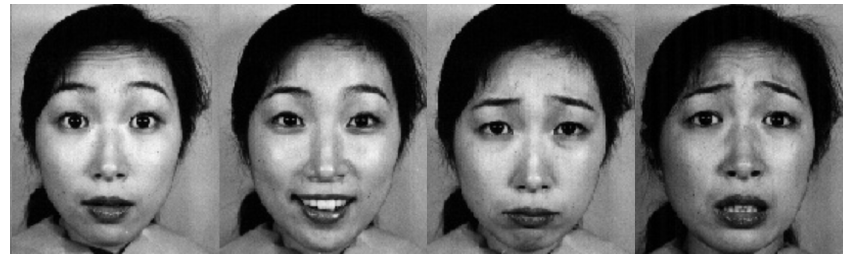
Figure 6. Four sample images from the JAFFE database.